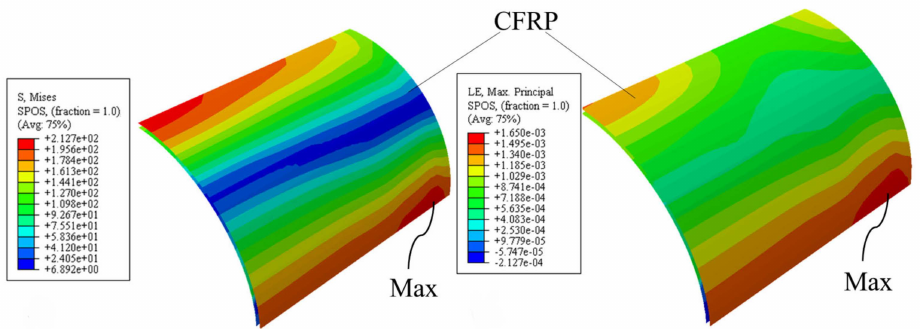
Figure 13. CFRP stress distribution diagram at limit